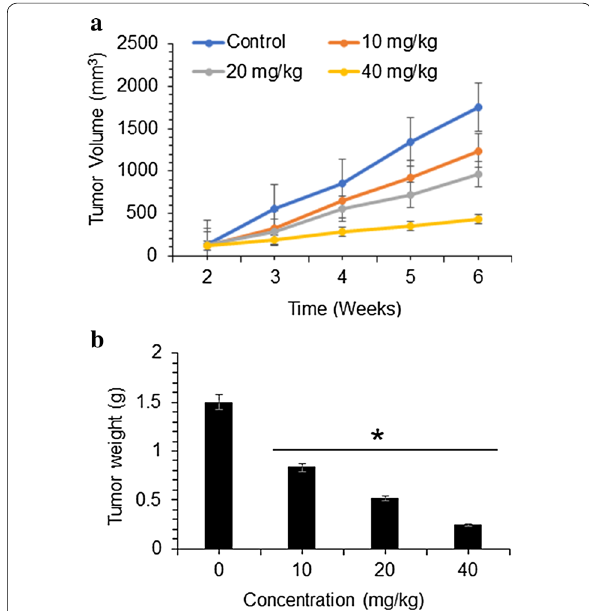
Fig. 5 Mukonal inhibits MDA-MB-231 and SK-BR-3 tumor growth in vivo. a Tumor volume and b tumor weight were measured at indicated time intervals and doses of mukonal molecule. All the experiments for separate drug concentration were executed three times and data was shown as mean SE (standard error). The p value ± of < 0.05 was taken as a statistical significant